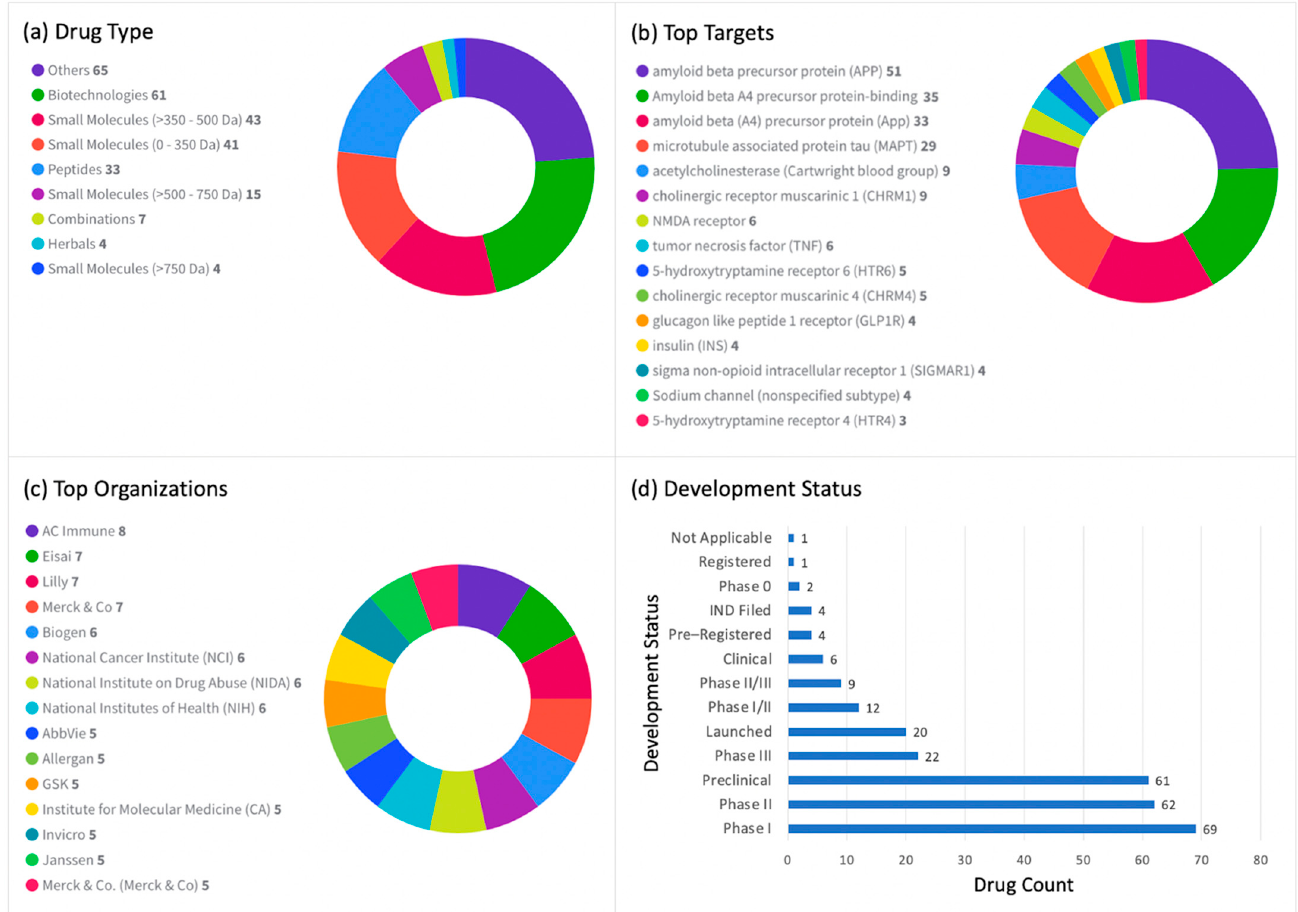
Figure 4. An overview of Alzheimer’s disease drug discovery pipeline under active development by ( a ) drug type, ( b ) top targets, ( c ) top organizations, and ( d ) development status. Under active development, according to Cortellis Drug Discovery Intelligence (CDDI) [40] database as of 10 October 2022. Data source: Cortellis Drug Discovery Intelligence, 10 October 2022, https://www.cortellis.com/drugdiscovery/ © 2022 Clarivate. All rights reserved.